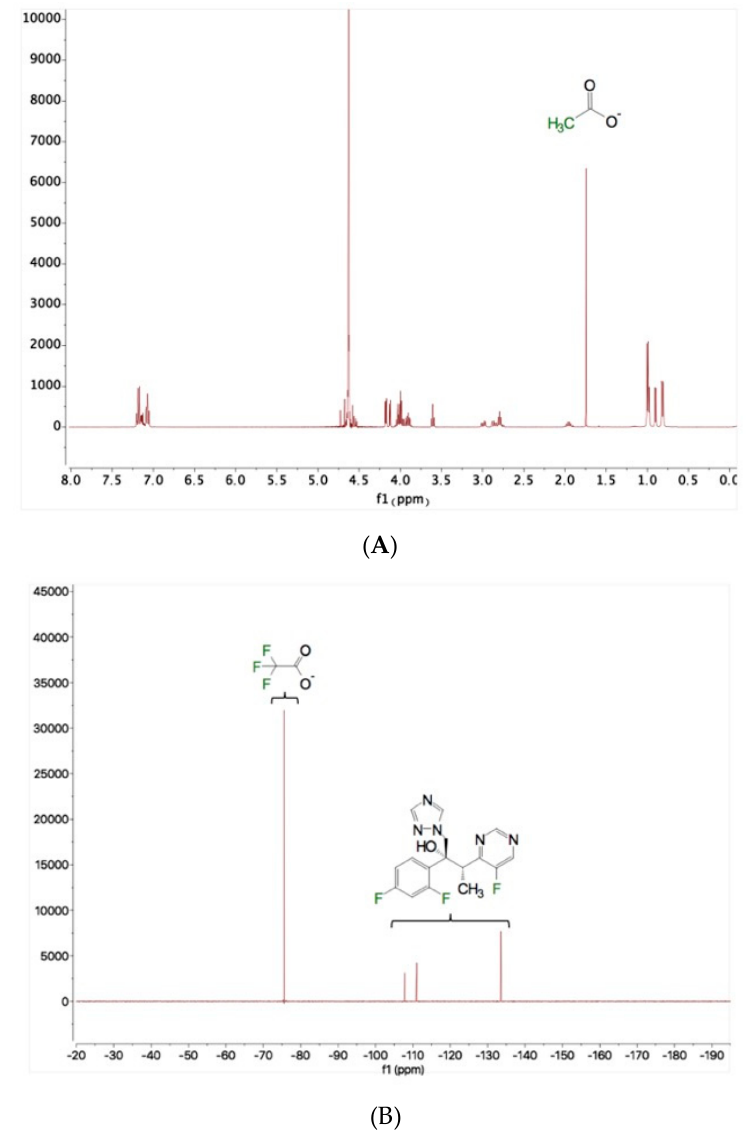
Figure 3. NMR spectrums of bulk powder: ( A ) 1 H-NMR spectrum of CSP7 acetate; ( B ) 19 F-NMR spectrum of CSP7 TFA.